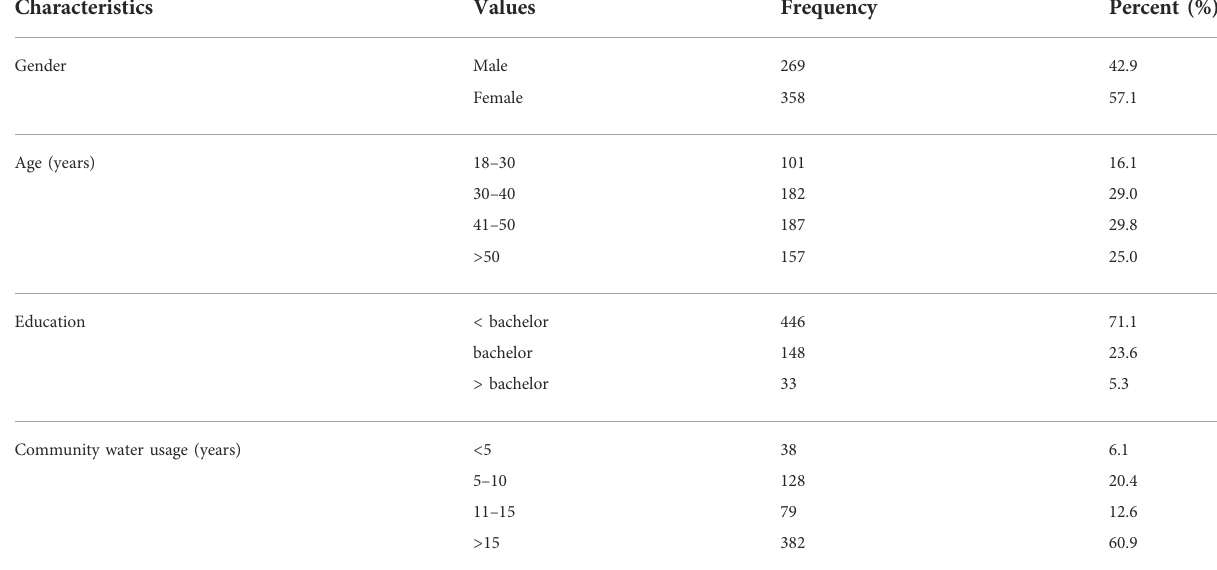
TABLE 1 Demographic data of primary testing respondents, Total (N = 627).